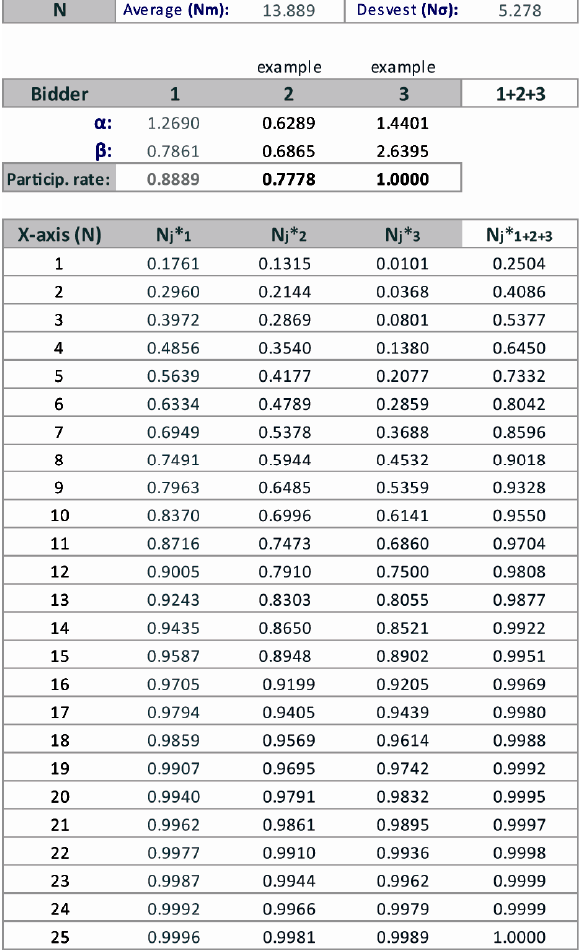
Table 5. Analysis of Position (j*) performances of a group of bidders for an upcoming tender